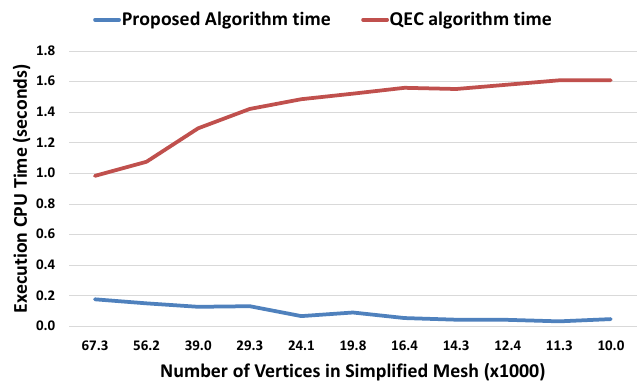
Figure 21. A comparison of the execution time of the proposed algorithm versus the QEC